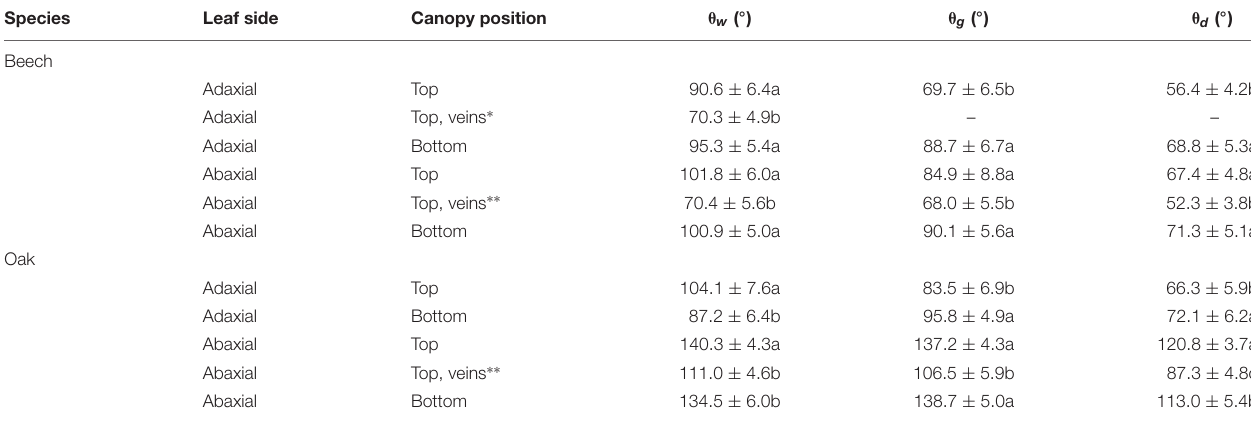
Data are means ± SD. Within columns and for the same species and leaf side, values marked with different letters are significantly different according to Duncan’s Multiple Range Test (P ≤ 0.05). ∗ Considering the continuous electron-lucent layer underneath the epicuticular waxes.